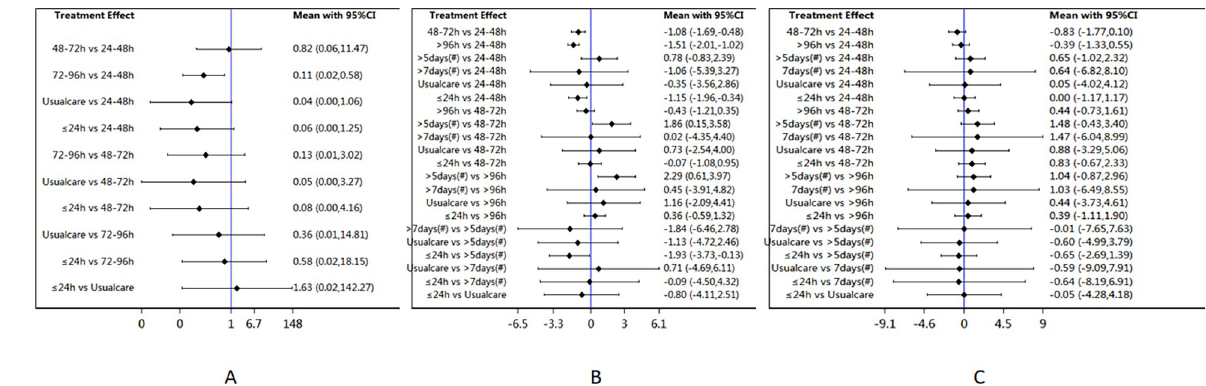
Fig 4. 95%CI: 95% Confidence Interval; (#): ICU admitted time.